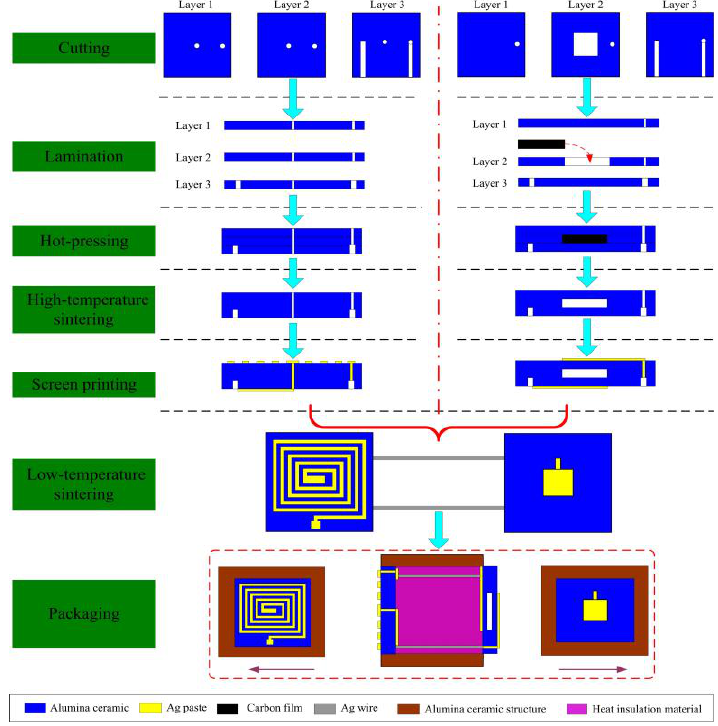
Figure 4. Fabrication